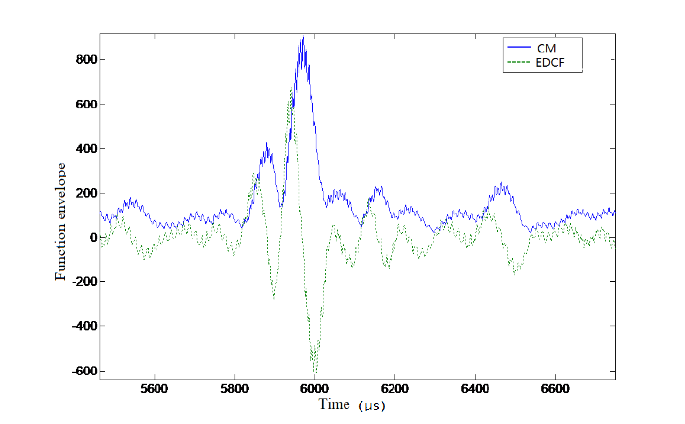
Figure 11. The correlation envelope function difference result in test data (the main